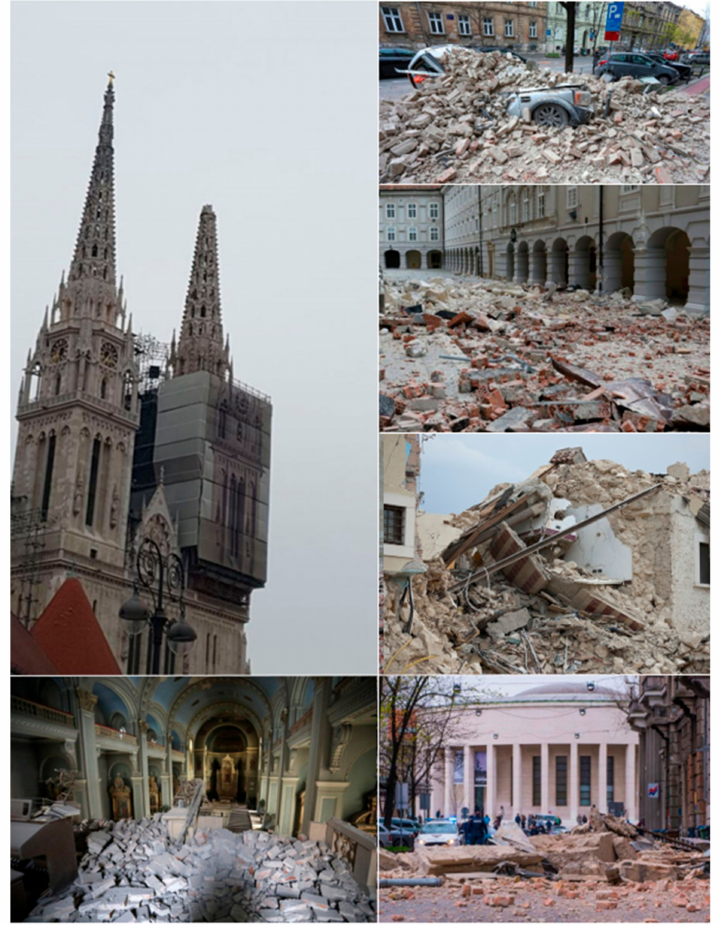
Figure 6. Photos of damage in Zagreb caused by the 22 March 2020